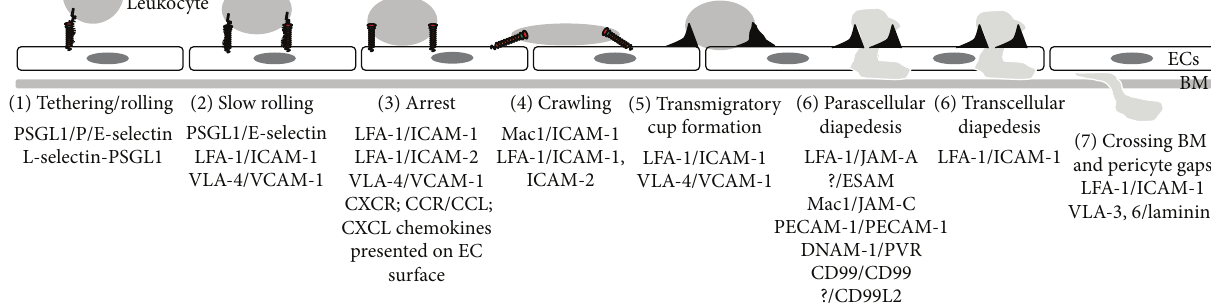
Figure 1: General scheme of the leukocyte extravasation cascade. The different steps of leukocyte interactions with endothelial cells during adhesion and transmigration are depicted. The known adhesion receptor interactions are listed for each step with the leukocyte receptor being named first. Unknown ligands are represented by question marks. During rolling, secondary rolling of leukocytes on already adherent leukocytes can occur that involve interactions of leukocyte L-selectin with leukocyte PSGL1 (not depicted). All receptors are connected to the actin cytoskeleton via actin-binding proteins to facilitate the extensive actin remodeling required for the morphological changes and movement of both cell types involved (not depicted). For details, see